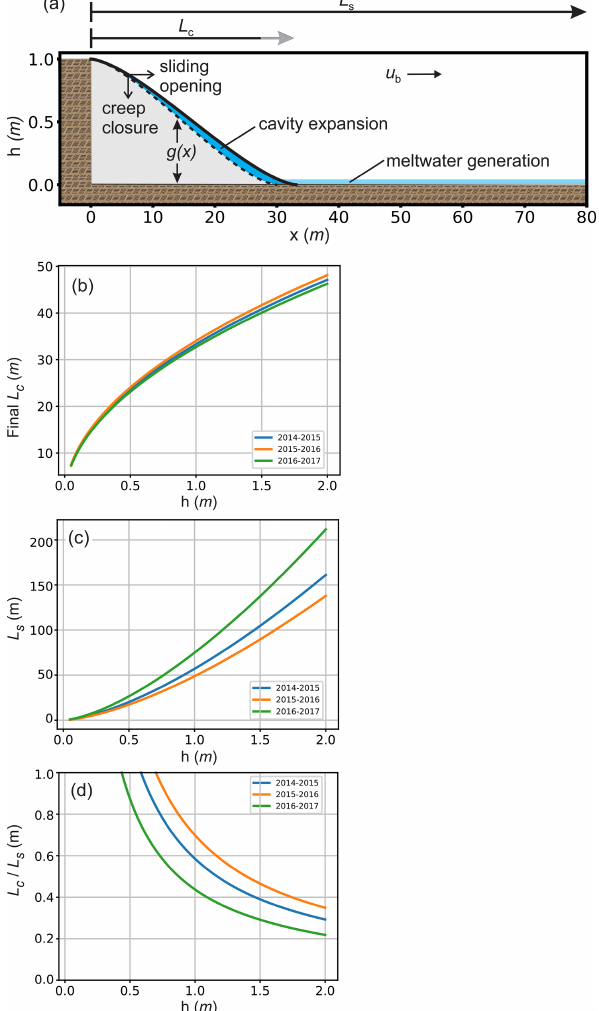
Figure 8. Cavity geometries based on the Kamb (1987) stepped-bed analysis. (a) Bed and cavity geometry, showing cavity expansion as sliding speed increased over the 2016–2017 winter. Labels corre- spond to terms in Eqs. (2)–(4) in the text. Model results for three different winter periods show the stable cavity lengths required to balance sliding speed, meltwater generation, and cavity expansion under the assumption of isolated cavities. Plotted are results for a range of potential step heights: (b) final cavity length after the cav- ity has expanded to accommodate the meltwater generated over the winter period; (c) length of steps required to accommodate both the water cavity and the portion of the step in contact with ice; (d) ratio of cavity length to step length, which must be less than 1 because cavities cannot be longer than their